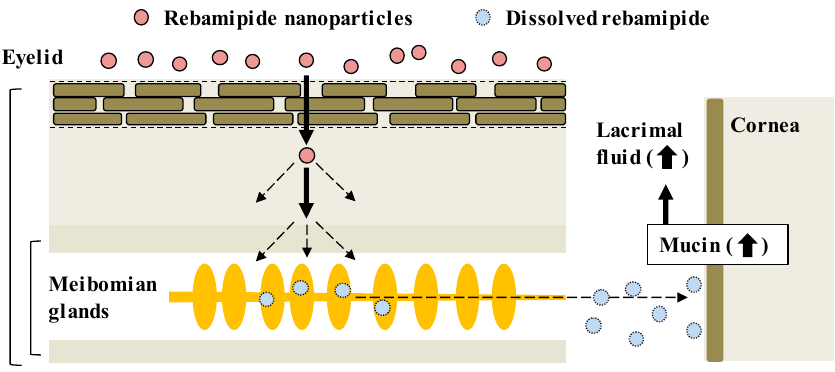
Figure 7. Drug delivery routes of rebamipide in REB-NPs, and the therapeutic mechanism for dry